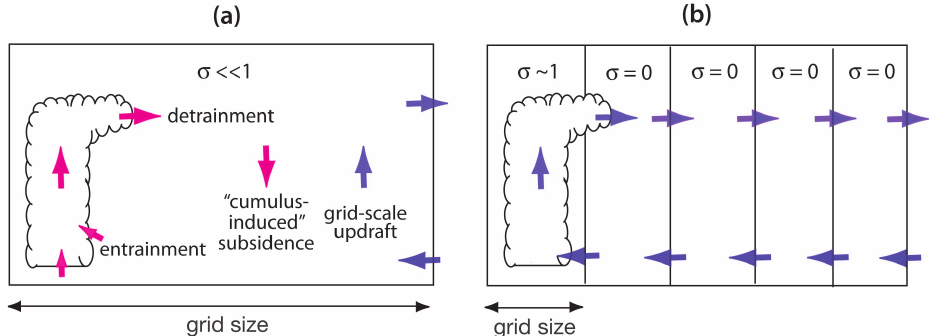
Fig. 5. Schematic illustration of circulations associated with clouds for (a) coarse and (b) fine resolutions.